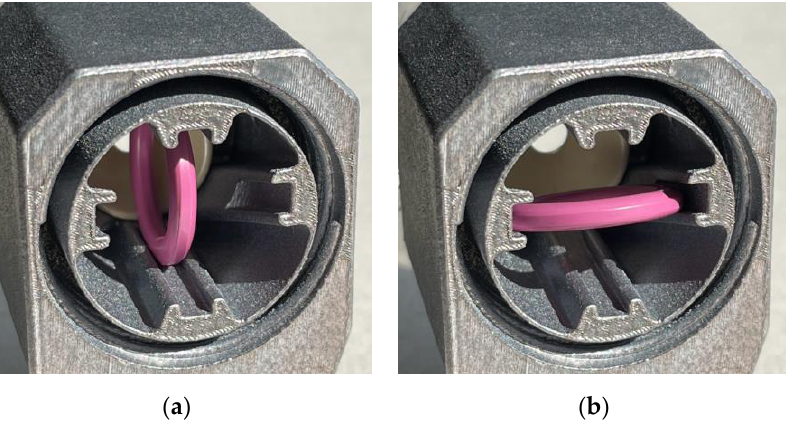
Figure 5. Install positions of ceramic ring in the cartridge holder in a rear view. ( a ) The fiber bundle passes the ring first on the left, then on the right, because of the resin inflow position; ( b ) the fiber bundle passes the ring first on the top, and then on the bottom, or the other way around depending on the required curvature.